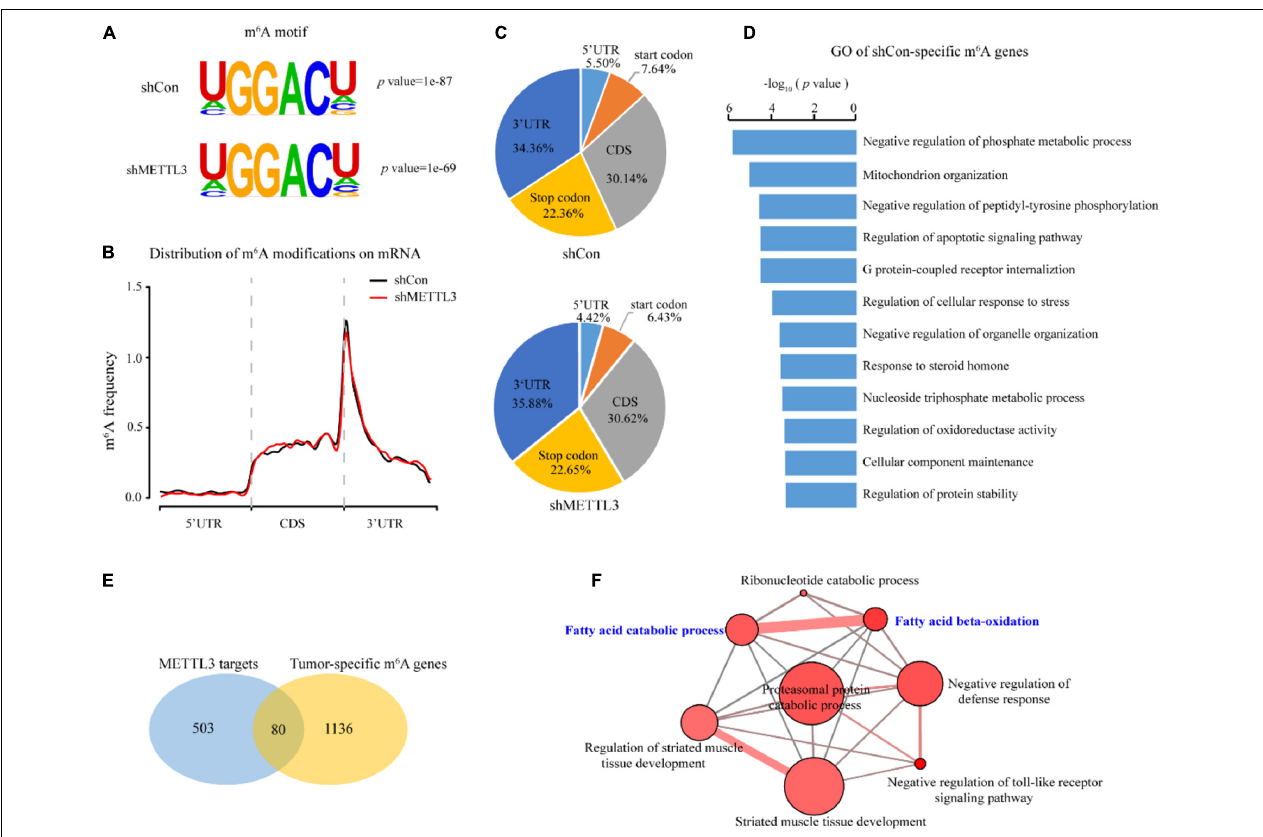
FIGURE 5 | Identification of METTL3 downstream targets in ccRCC. (A) Predominant consensus motif identified in the shCon and shMETTL3 A498 cells. (B) The normalized distribution of m 6 A peaks across all mRNA transcripts after METTL3 knockdown. (C) The fractions of the m 6 A peaks in the control and METTL3 knockdown A498 cells within the indicated regions. (D) GO pathway analysis of the candidate METTL3 targets in the ccRCC cell line. (E) Schematic of the selection for the downstream targets of METTL3 in the ccRCC cell lines and the ccRCC tissues. (F) CPDB analysis of 80 candidate targets. P -values were calculated according to Fisher’s exact test, cutoff p <